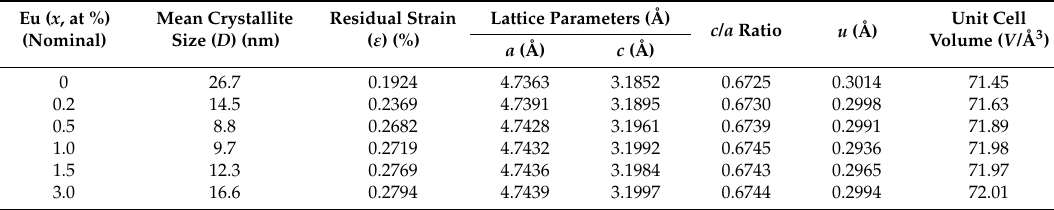
Table 1. List of crystallite size, residual strain, lattice parameters obtained from the XRD data of the layered Eu-doped SnO 2 nanorods